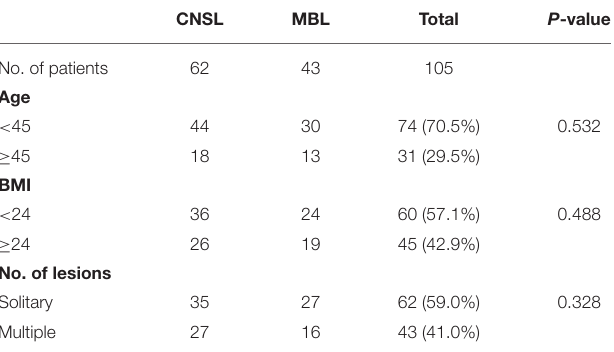
TABLE 1 | Patient characteristics. TABLE 2 | Lesion